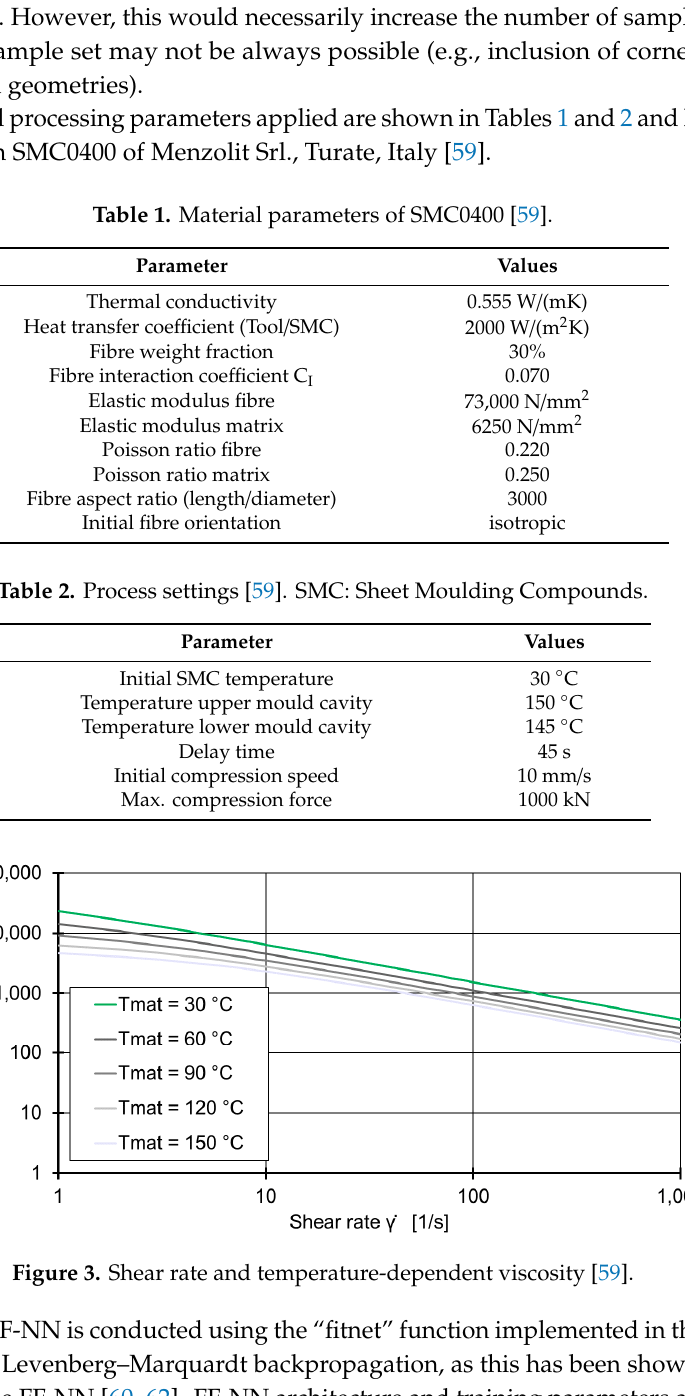
( b ) ( c ) Figure 4. Preform geometries used in initial metamodel validation: validation geometry 1 ( a ), validation geometry 2 ( b ), validation geometry 3 ( c ). 2.3. Optimisation The optimisation of a performance metric of an SMC-based component can be defined as a multivariable optimisation problem (MVO). The mathematical description of an MVO is [63–65]: 𝑚𝑖𝑛 (𝑓(𝑥)), 𝑥 ∈ 𝑆